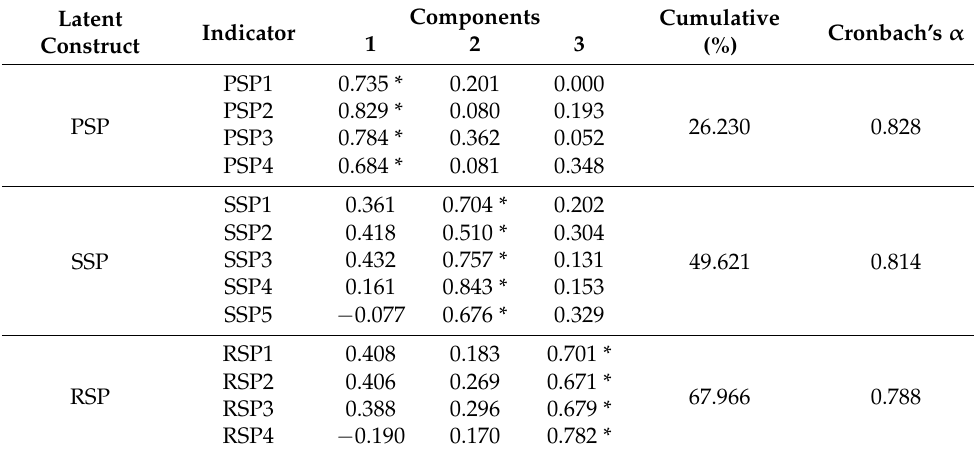
Table 1. Results of the EFA for soundscape perception.